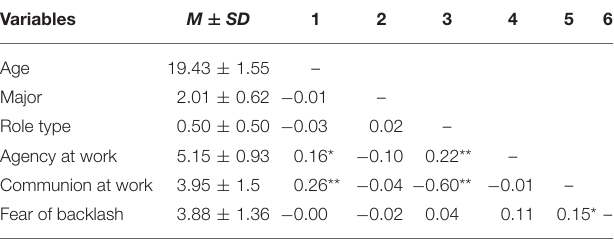
TABLE 2 | Descriptive statistics and correlations in Study